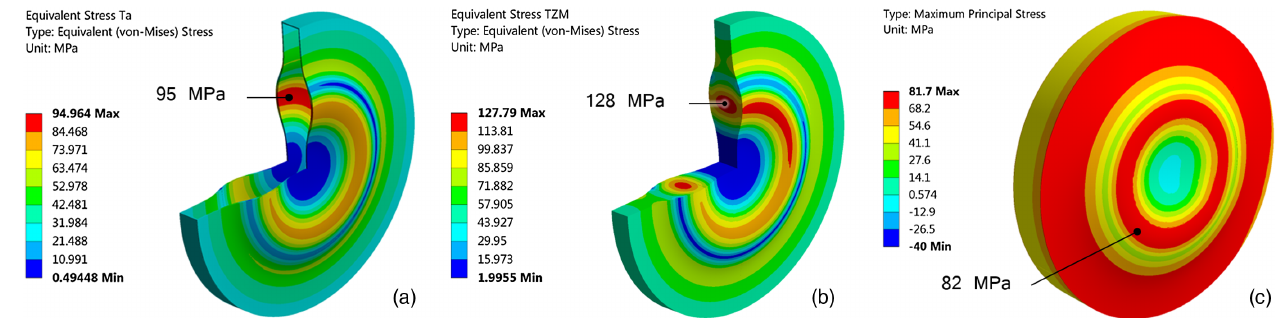
FIG. 5. Von Mises equivalent stress or maximum principal stress distribution after one beam pulse in the most loaded blocks for each target material. (a) Ta2.5W cladding of block no. 4, maximum equivalent stress (95 MPa) reached in the beam impact region at the interface with the block core. (b) TZM core of block no. 4, maximum equivalent stress (130 MPa) found in the core center (mainly due to high compressive stresses) and in the interface with the tantalum cladding. (c) W core of block no. 14, highest value of maximum principal stress reached in the upstream face of the block, following the beam dilution